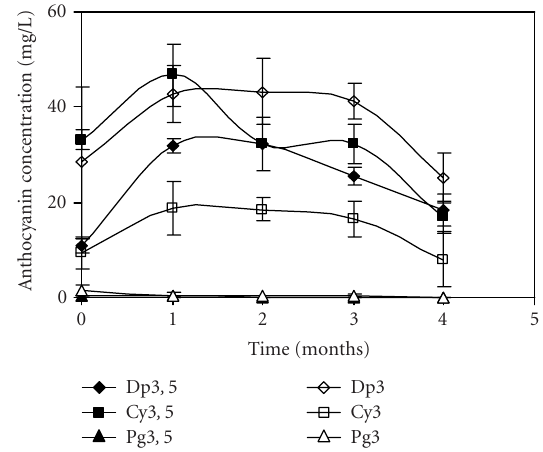
Figure 7. Evolution of delphinidin 3,5-diglucoside (Dp3,5), cyanidin 3,5-diglucoside (Cy3,5), pelargonidin 3,5-diglucoside (Pg3,5), delphinidin 3-glucoside (Dp3), cyanidin 3-glucoside (Cy3), and pelargonidin 3-glucoside (Pg3) concentration in “As- saria” pomegranate juice from fruits treated with 1 . 5% CaCl 2 plus Brillaqua wax, during storage at 5 ◦ C. The concentrations of anthocyanins were calculated from standard curves of Dp3,5; Dp3; Cy3,5; Cy3, Pg3,5, and Pg3. Bars represent standard devi- ations of four